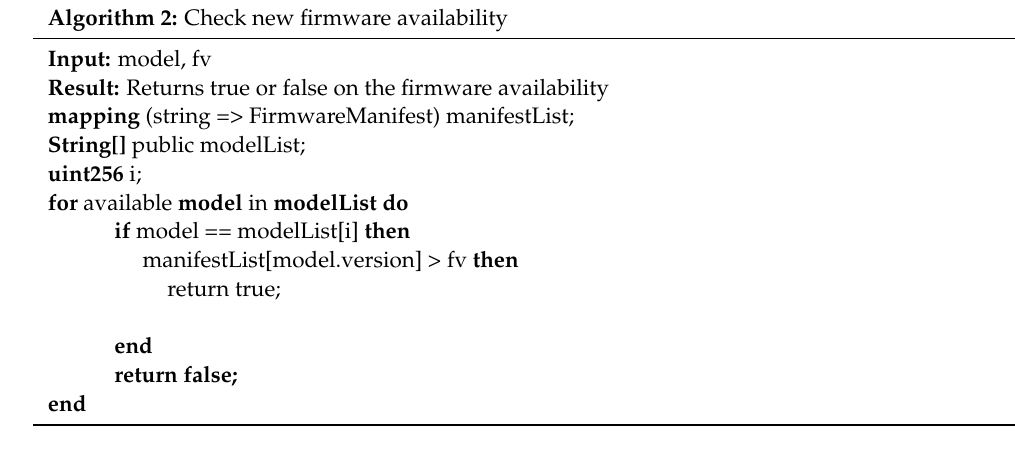
Algorithm 2: Check new firmware availability